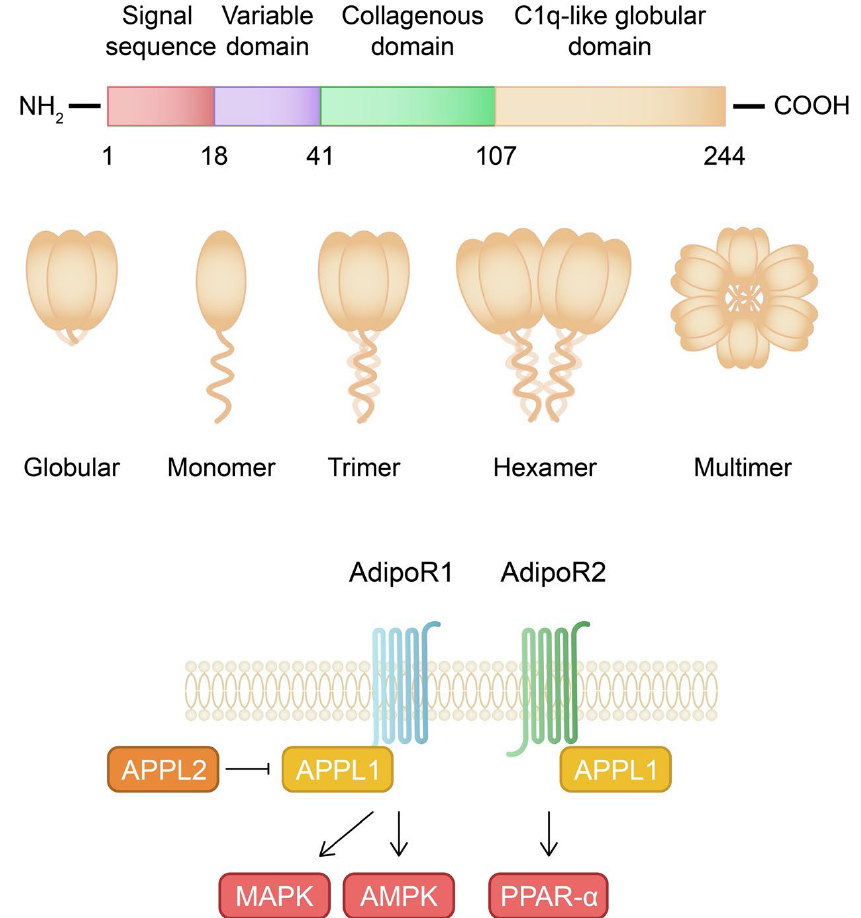
Figure 1. Schematic representation of the adiponectin isoforms and signaling. AdipoR1—adiponectin receptor 1; AdipoR2—adiponectin receptor 2; APPL—adaptor protein containing PH domain, PTB domain, and leucine zipper motif-1; AMPK—AMP-activated protein kinase; MAPK—mitogen- activated protein kinase; PPAR—peroxisome proliferator-activated receptor.